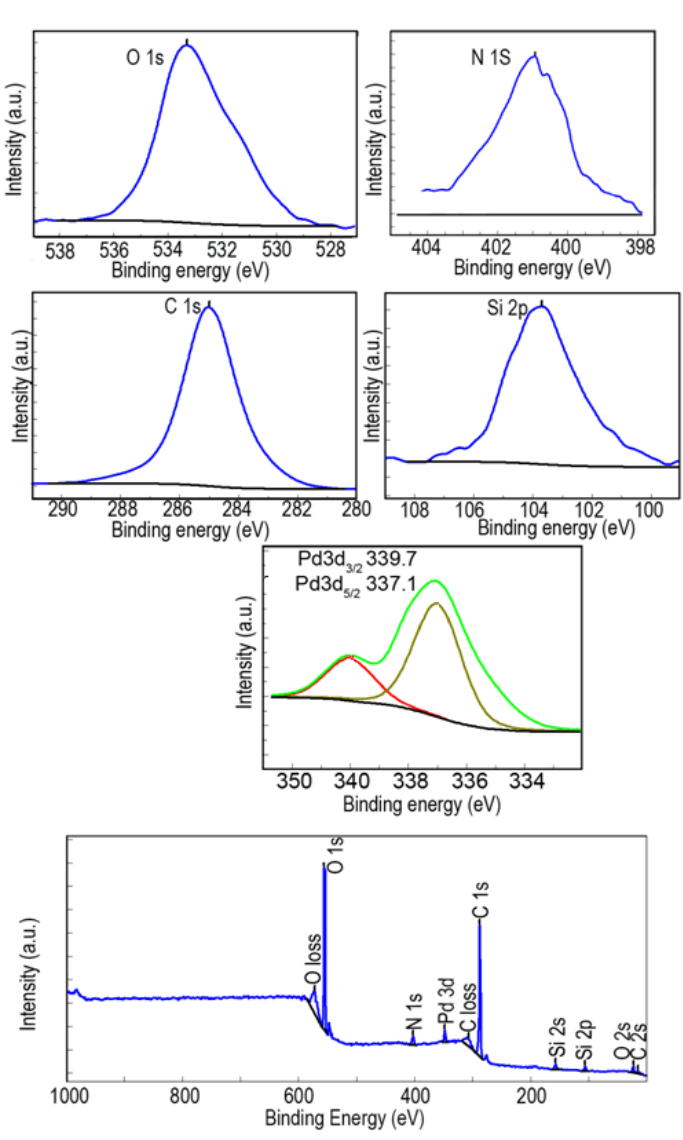
Fig. 8. XPS spectra of O 1s, N 1s, C 1s, Si 2p, Pd 3d and Pd@modified Figure 8. XPS spectra of O 1s, N 1s, C 1s, Si 2p, Pd 3d and Pd@modified SBA‐15